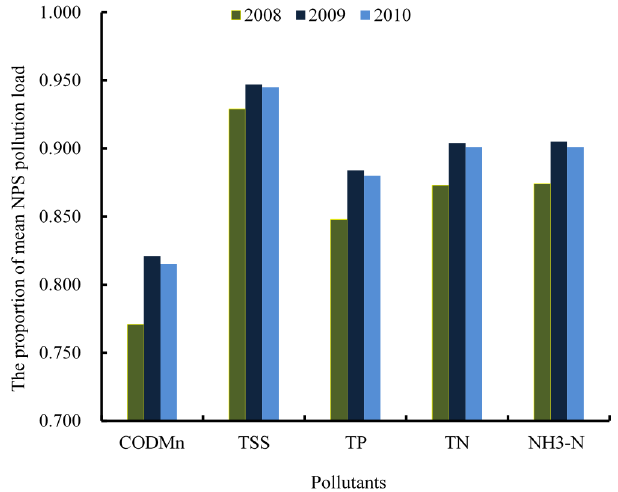
Figure 3. The proportions of mean NPS pollution loads for each